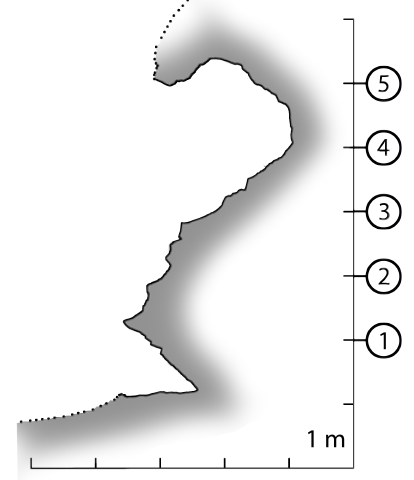
Figure 10. Vertical section of the rock-shelter. Parietal repre- sentations are located between horitontal sections 4 and 5.